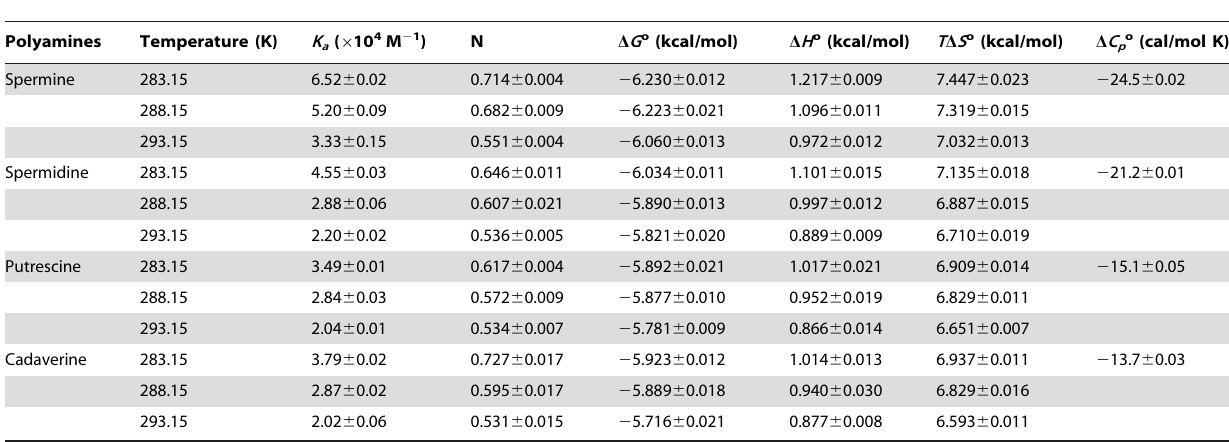
Table 3. ITC derived thermodynamic parameters for the binding of polyamines to MLDNA a .